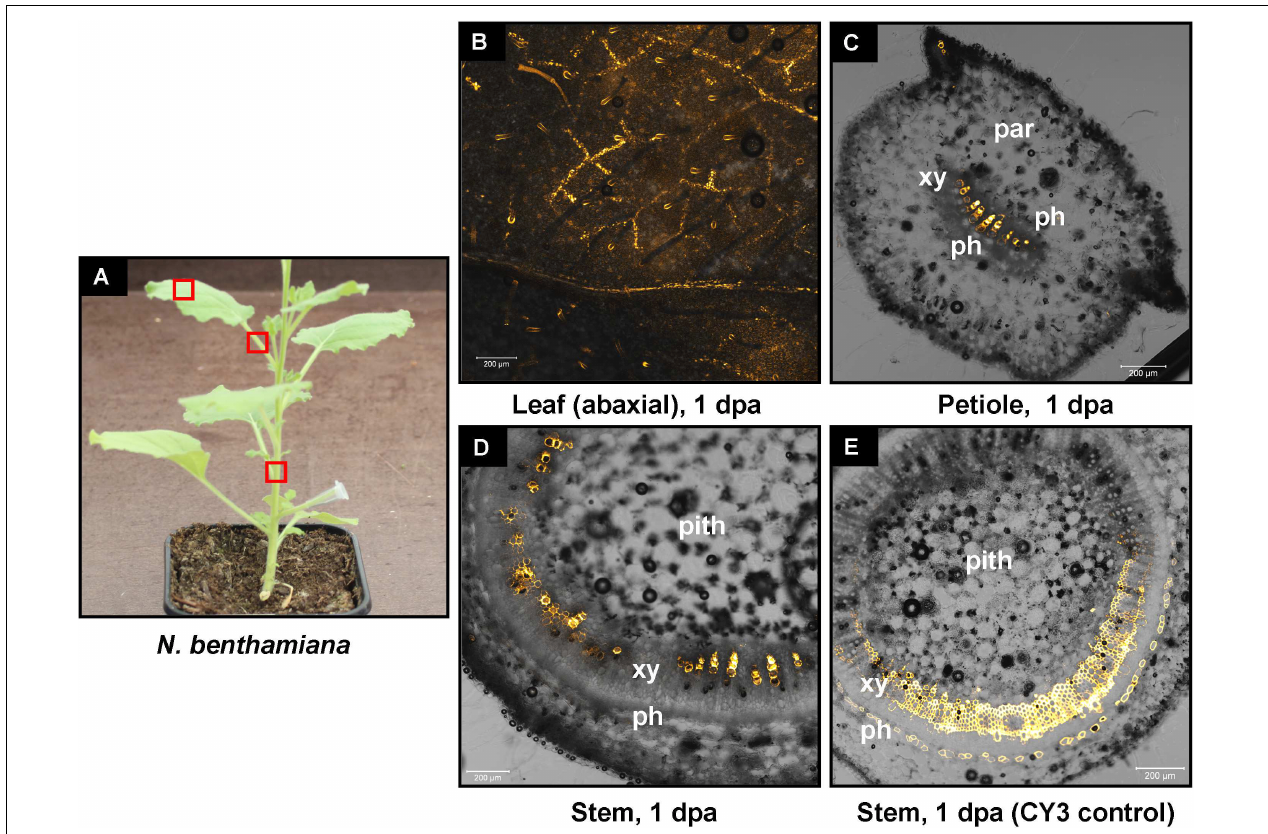
FIGURE 7 | Delivery of CY3-labeled hpRNA by petiole absorption to N. benthamiana . (A) Red boxes indicate parts of the plant that were subjected to microscopy 1 dpa. (B) Confocal microscopy of the abaxial side of a leaf. (C) Confocal microscopy of the petiole (cross section) of a leaf. (D) Confocal microscopy of the stem (cross section) above the site of CY3-labeled hpRNA application. (E) Delivery of free CY3 dye (not conjugated to RNA molecule) by petiole absorption to N. benthamiana . Confocal microscopy of the stem (cross section) above the site of CY3 dye application. Abbreviations: xy, xylem; ph, phloem; par, parenchymatic